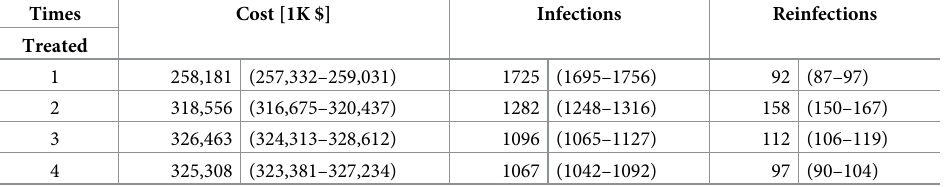
Table 5. Mean treatment costs, new chronic infections, and chronic reinfections (95% CI) during the treatment period (years 2020–2030) for DAA treatment rate of 7.5% per year and treatment adherence of 90%, by number of DAA courses allowed. The DAA cost per treatment is $25,000. Cost values are rounded to the nearest 1K$ and infec- tions are rounded to the nearest integer. Times Cost [1K $] Treated